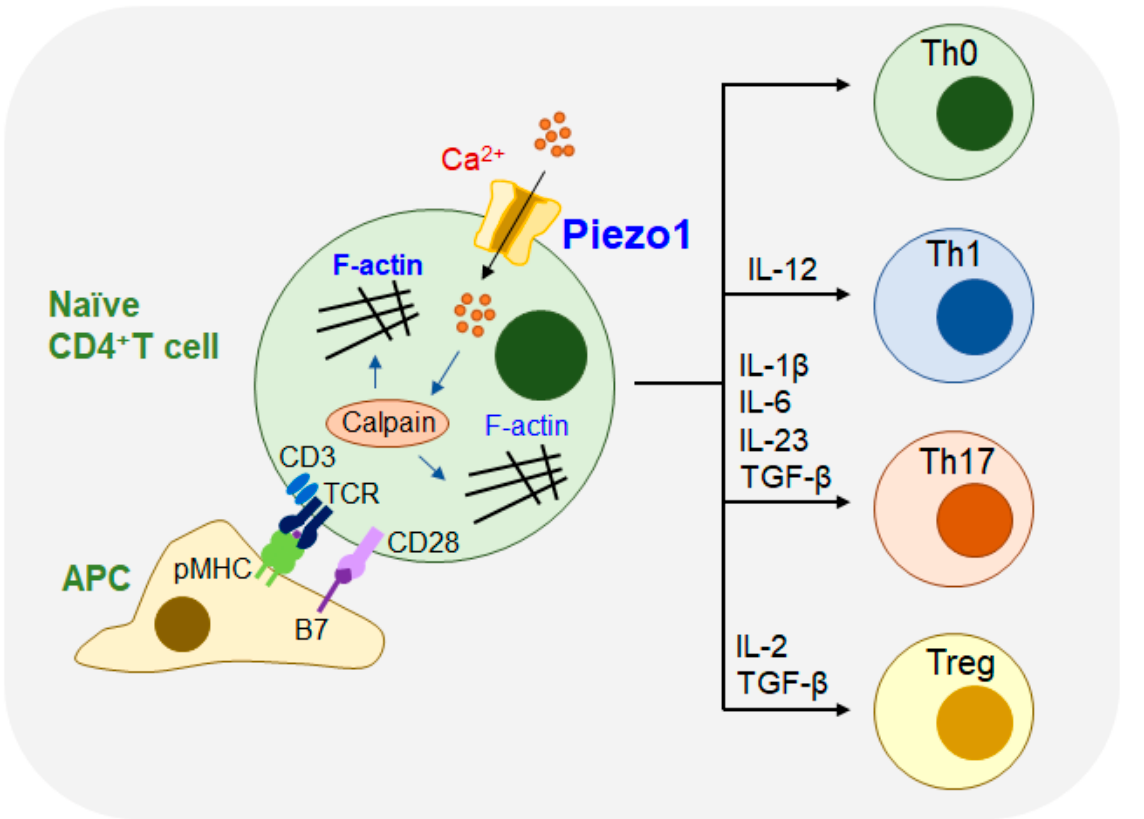
Figure 4. Piezo1 activates different subsets of CD4 + T cells. Different subsets of T cells are activated or recognized by short peptides, such as CD4 + T cells on antigen-presenting cells (APCs) by T cell receptor (TCR) or cross-linked antibodies immobilized on magnetic beads and induced by specific cytokines. In T cells, Piezo1 can promote extracellular Ca 2+ influx. Piezo1-mediated Ca 2+ influx was further induced by CD3/CD28 antibody or anti-CD3/anti-CD28 antibody. Piezo1 activates Ca 2+ influx and calpain expression in response to mechanical stimulation, leading to cytoskeletal rearrangement. Thus, TCR recognition of peptides on major histocompatibility complex (MHC) molecules can promote traction force production and Ca 2+ influx of T cells, ultimately leading to T cell